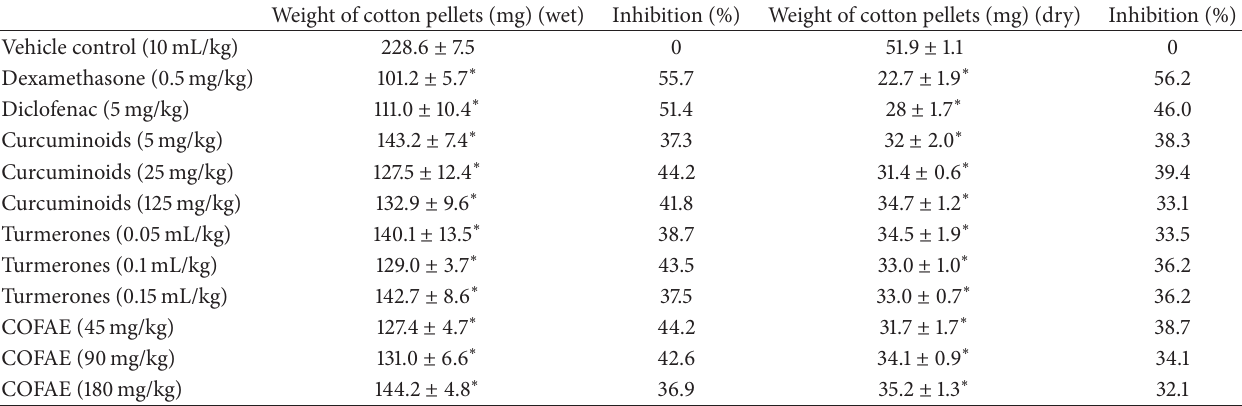
Table 2: Effect of curcuminoids, turmerones, and COFAE on cotton pellet-induced granuloma in rats. Weight of cotton pellets (mg)